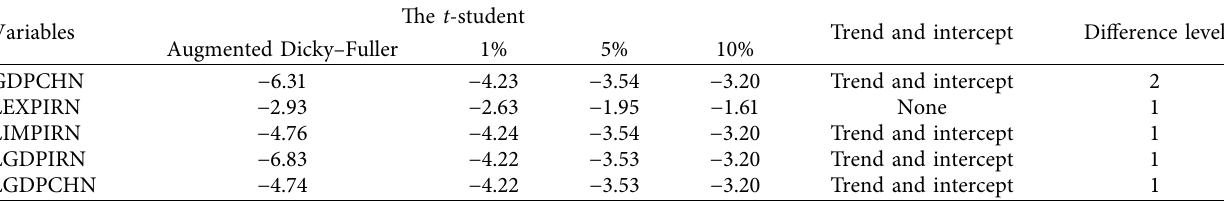
Figure 2: Schematic depiction of a Truel between the three states with three diferent relative power statuses. Table 2: Augmented Dicky–Fuller unit root